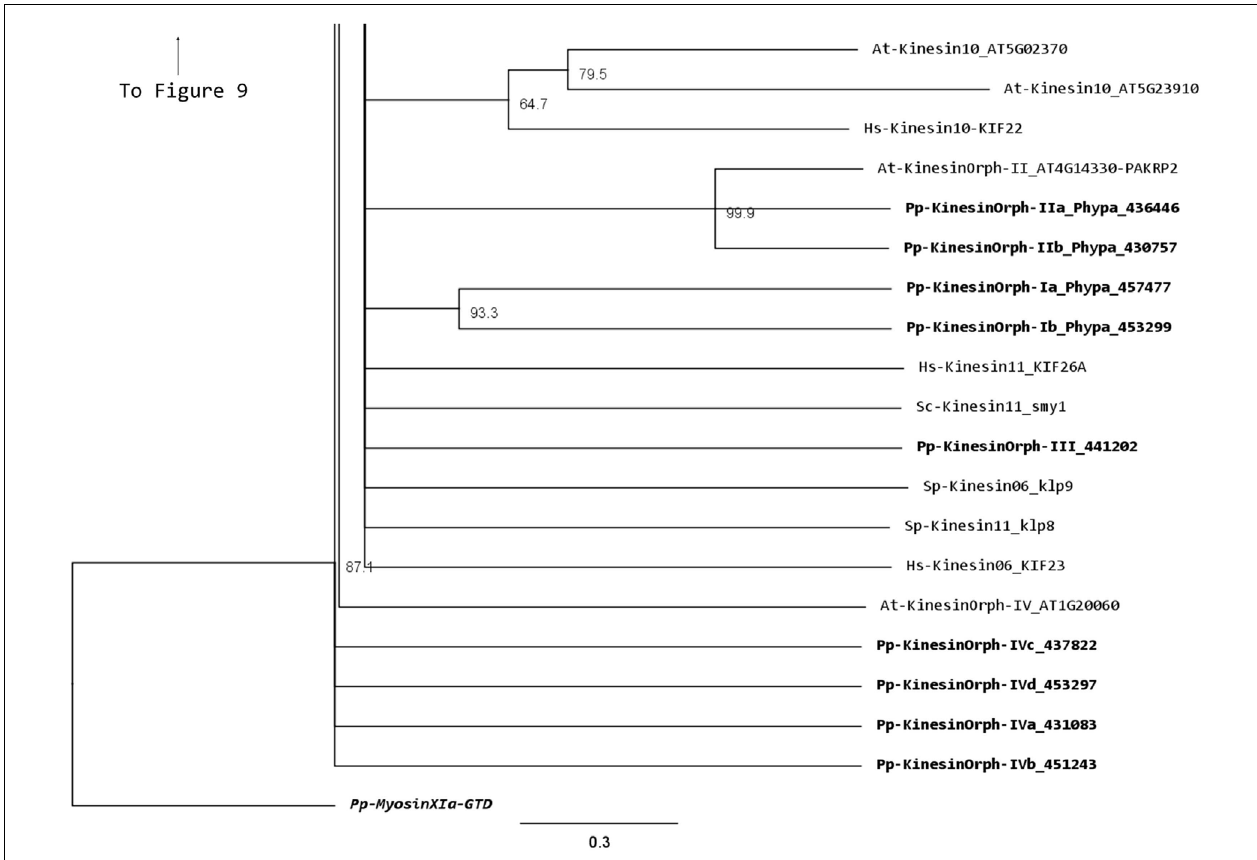
Numbers on the nodes show the statistical support of values above 50%.The scale shows the estimated branch length corresponding to the number of substitutions per site.The Physcomitrella numbers correspond to the Phypa number uniquely associated with each gene model (version 1.6) at